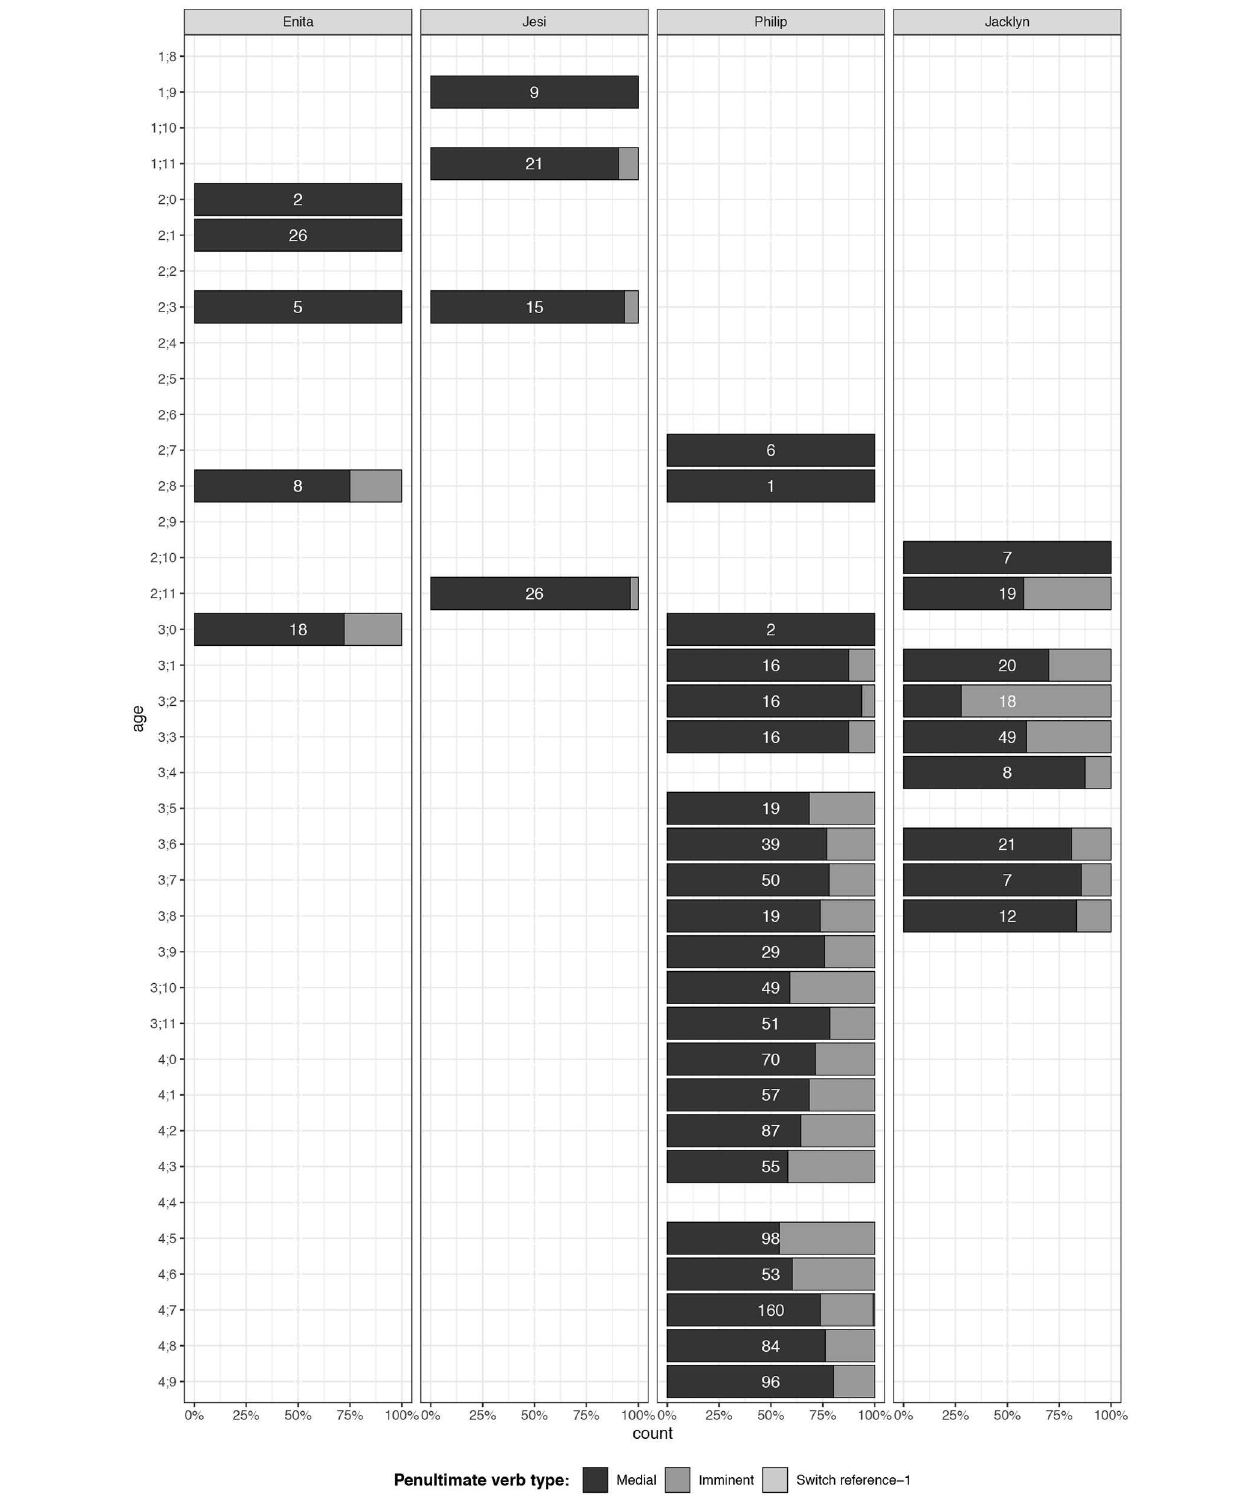
FIGURE 2 | Proportions of verb types in the next-to-last clauses of the children’s clause chains.